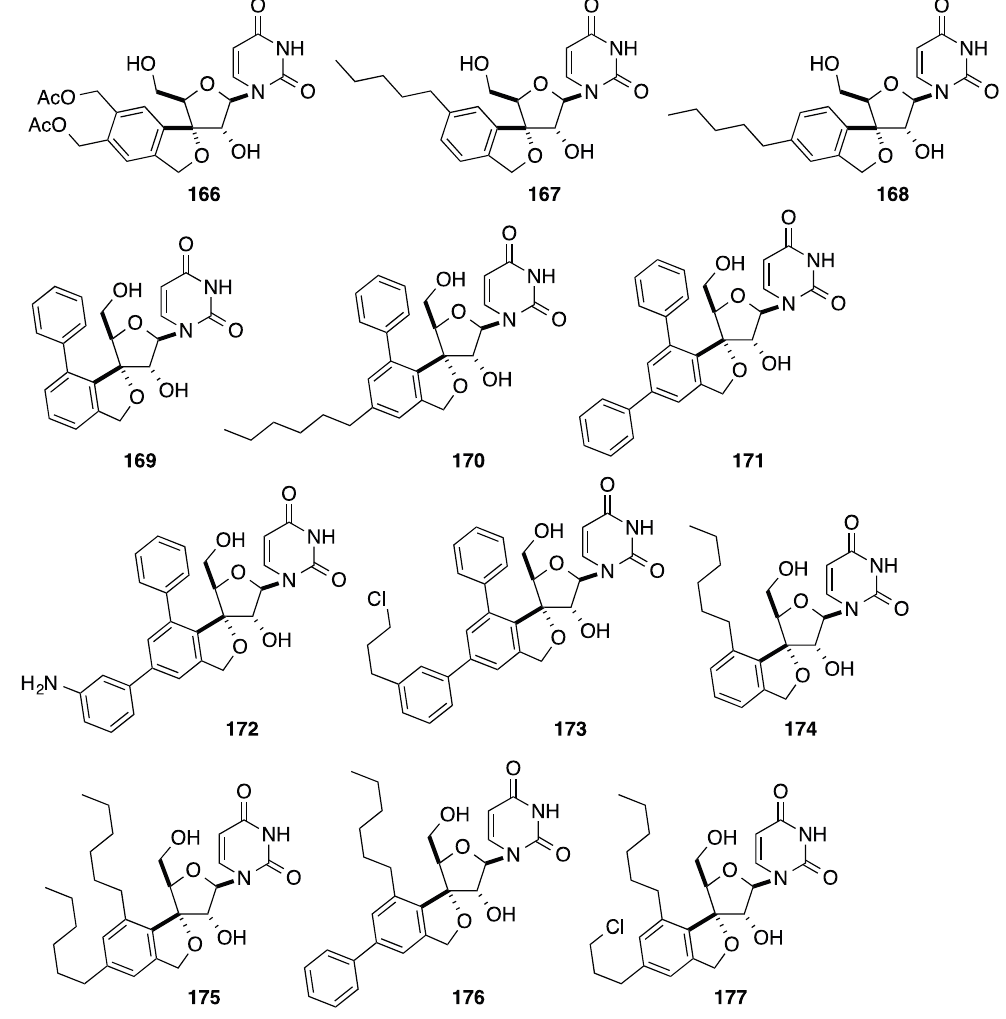
Figure 9. 3'- C -Spiro uridine analogues 166 – 177